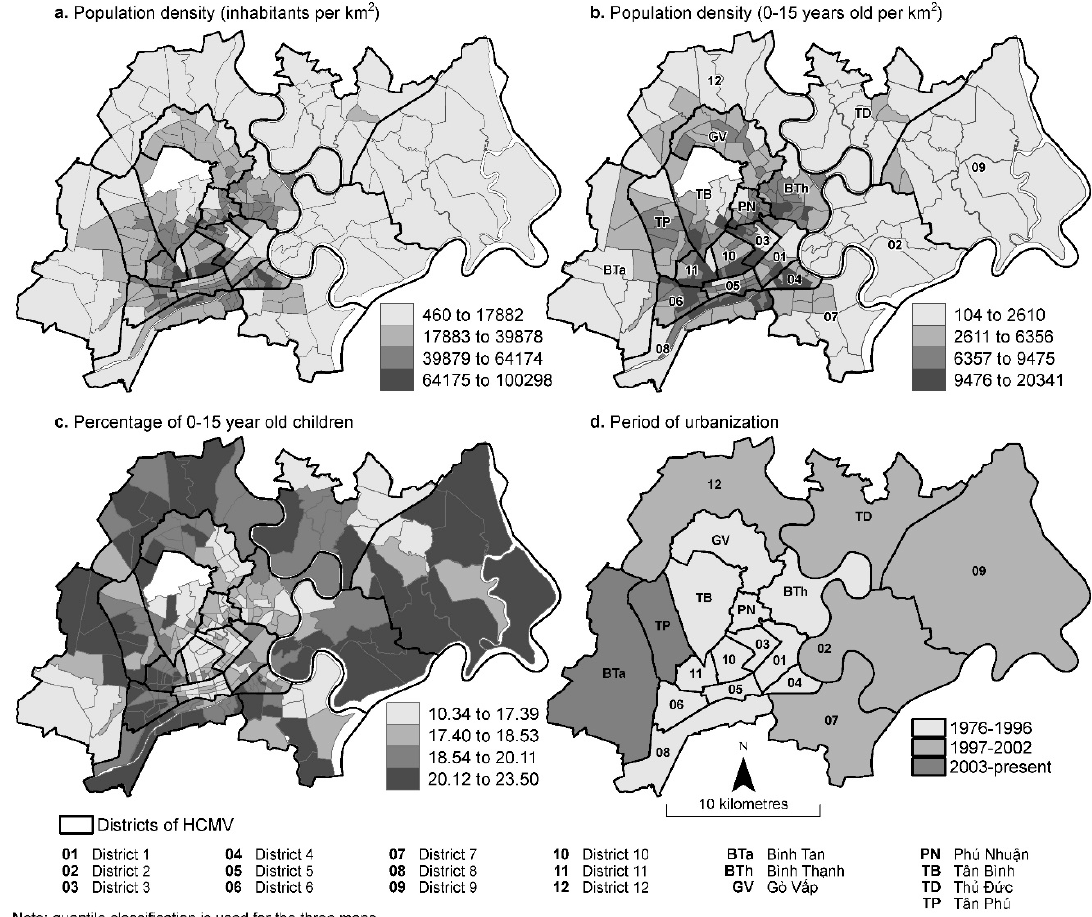
Figure 1. Population variables at the wards level and periods of urbanization in the city.